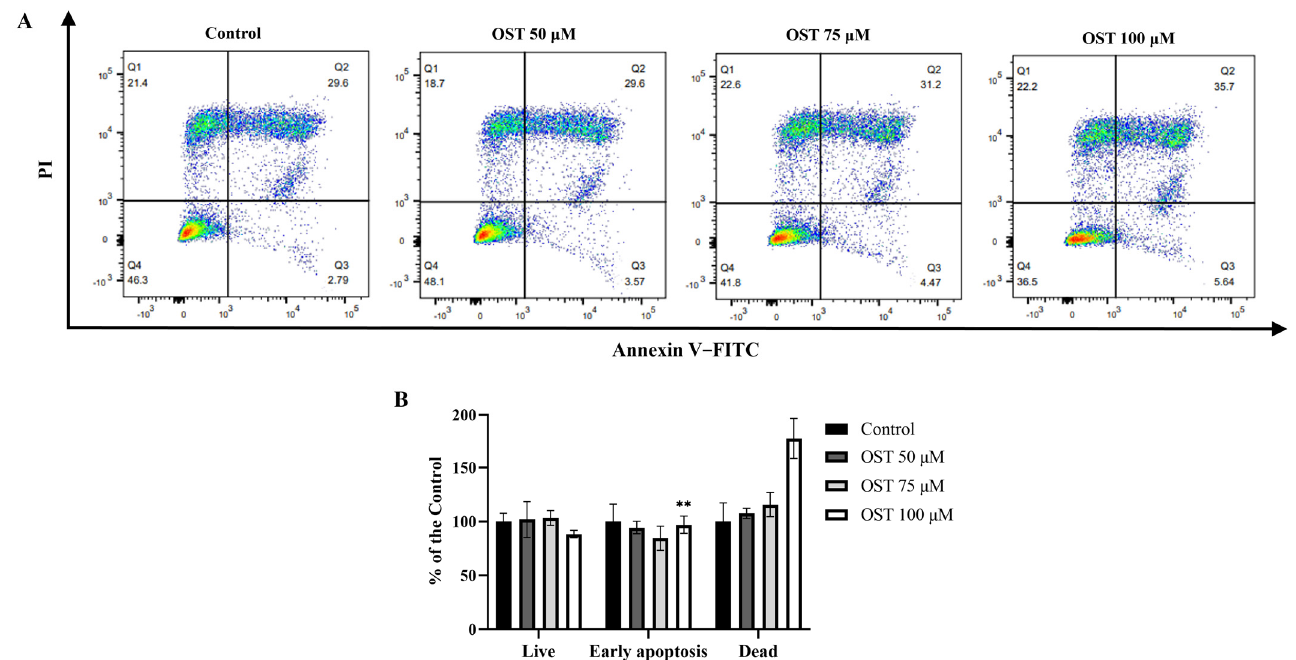
Figure 4. Effect of osthole (OST) on apoptosis of 4T1 cells. ( A ) 4T1 cells were treated with OST (0, 50, 75, and 100 μ M) for 24 h. Apoptosis and cell death induction were detected in an Annexin VFITC /PI double staining assay. ( B ) Mean percentage of cells in each quadrant of 4T1 cells after OST treatment. Viable cells were considered as FITC Annexin V − /PI − ; early apoptosis cells were considered as FITC Annexin V + /PI − ; and late apoptosis/dead cells were identified as FITC Annexin V + /PI + . Compared to that in the control group, Mean ± SD, N = 3, * p < 0.05, ** p < 0.01.